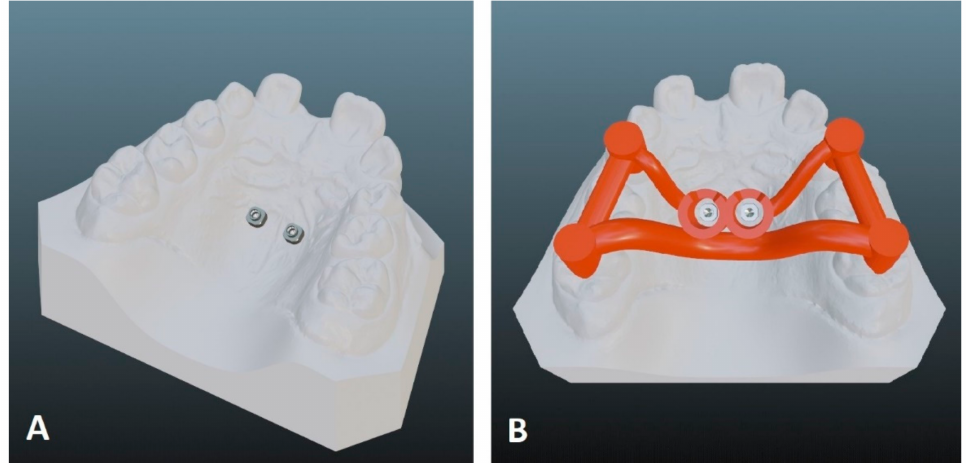
Figure 2. ( A ) Virtual implant planning on a digital model. ( B ) Virtual design of an insertion guide, that can be 3D-printed (software: Blender, Blender